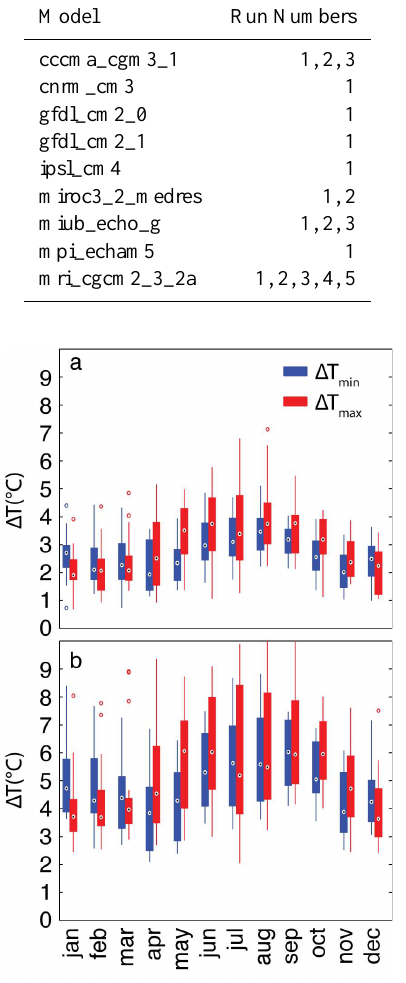
Fig. 4. Change in T min (blue) and T max (red) for (a) mid-century, and (b) end of century. The box and whiskers depict the 25th, me- dian, and 75th percentiles of the range of the 9 models considered. The individual runs of each model have been averaged to create a single ensemble member for each model.